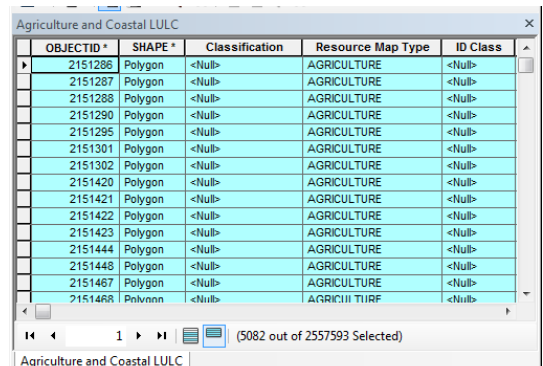
Figure 9. Sample Schema with NULL Values